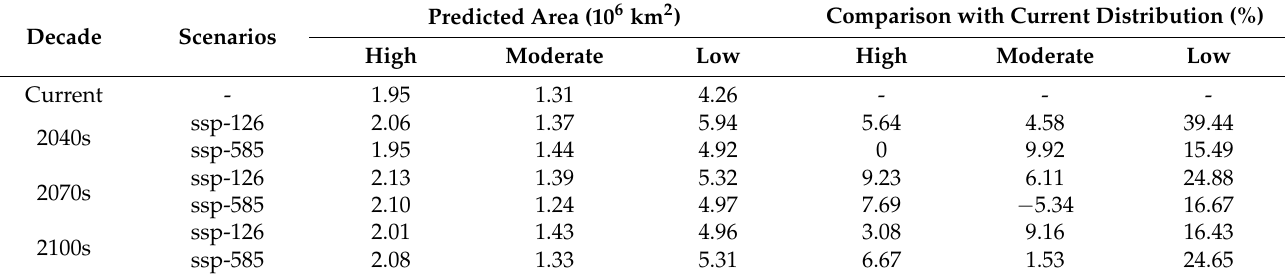
Figure 5. The changes in potential suitable areas of M. alternatus in different periods compared with the present. Table 3. The difference in potential suitable areas for M. alternatus under current and future climate